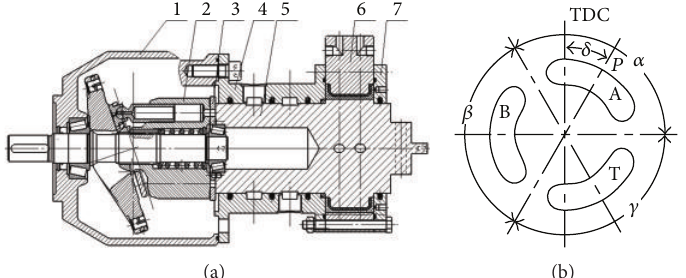
Figure 1: Simplified schematic of HHEC.